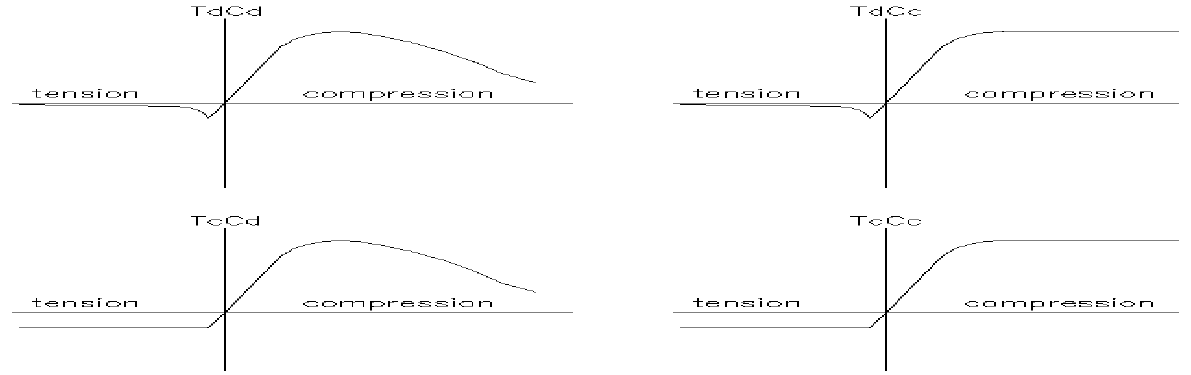
Figure 14: Modifications of the concrete material law (uniaxial strain–stress curves, concrete-damaged plasticity model) for purposes of different numerical simulations.